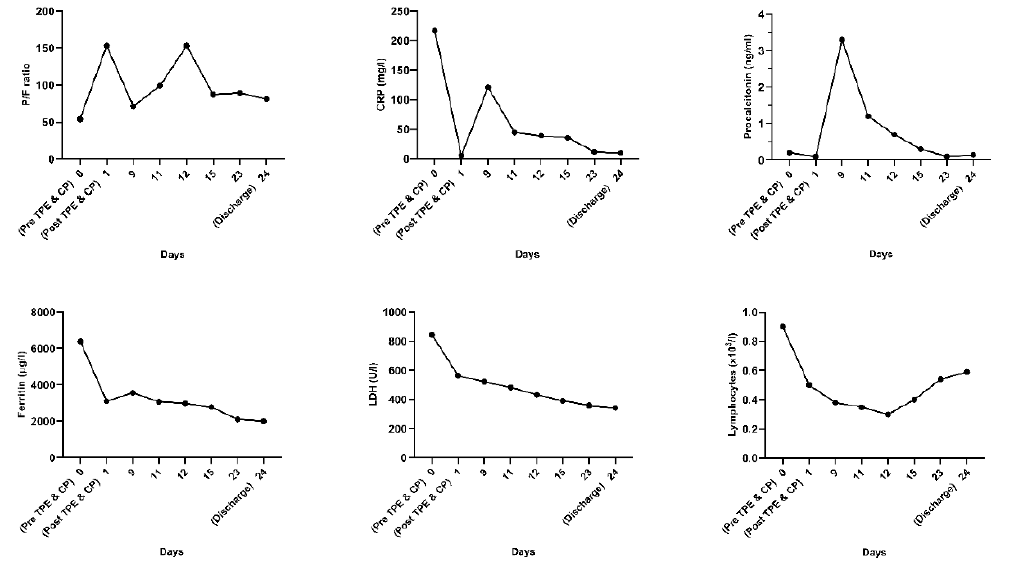
Figure 2. Dynamic graphic analysis of oxygenation (P/F ratio) and inflammatory markers. After the procedure (therapeutic plasma exchange followed by convalescent plasma transfusion), an improvement in oxygenation and a decrease in inflammatory markers could be noticed.